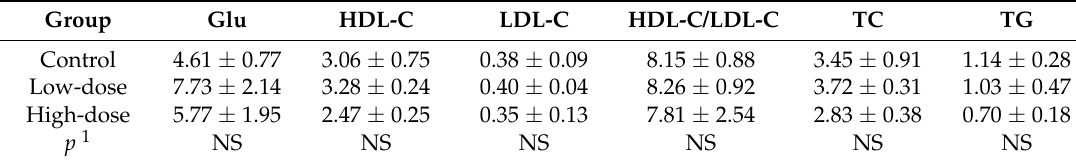
Table 1. Serum biochemical markers in mice. Glucose (Glu), total cholesterol (TC), triglyceride (TG),